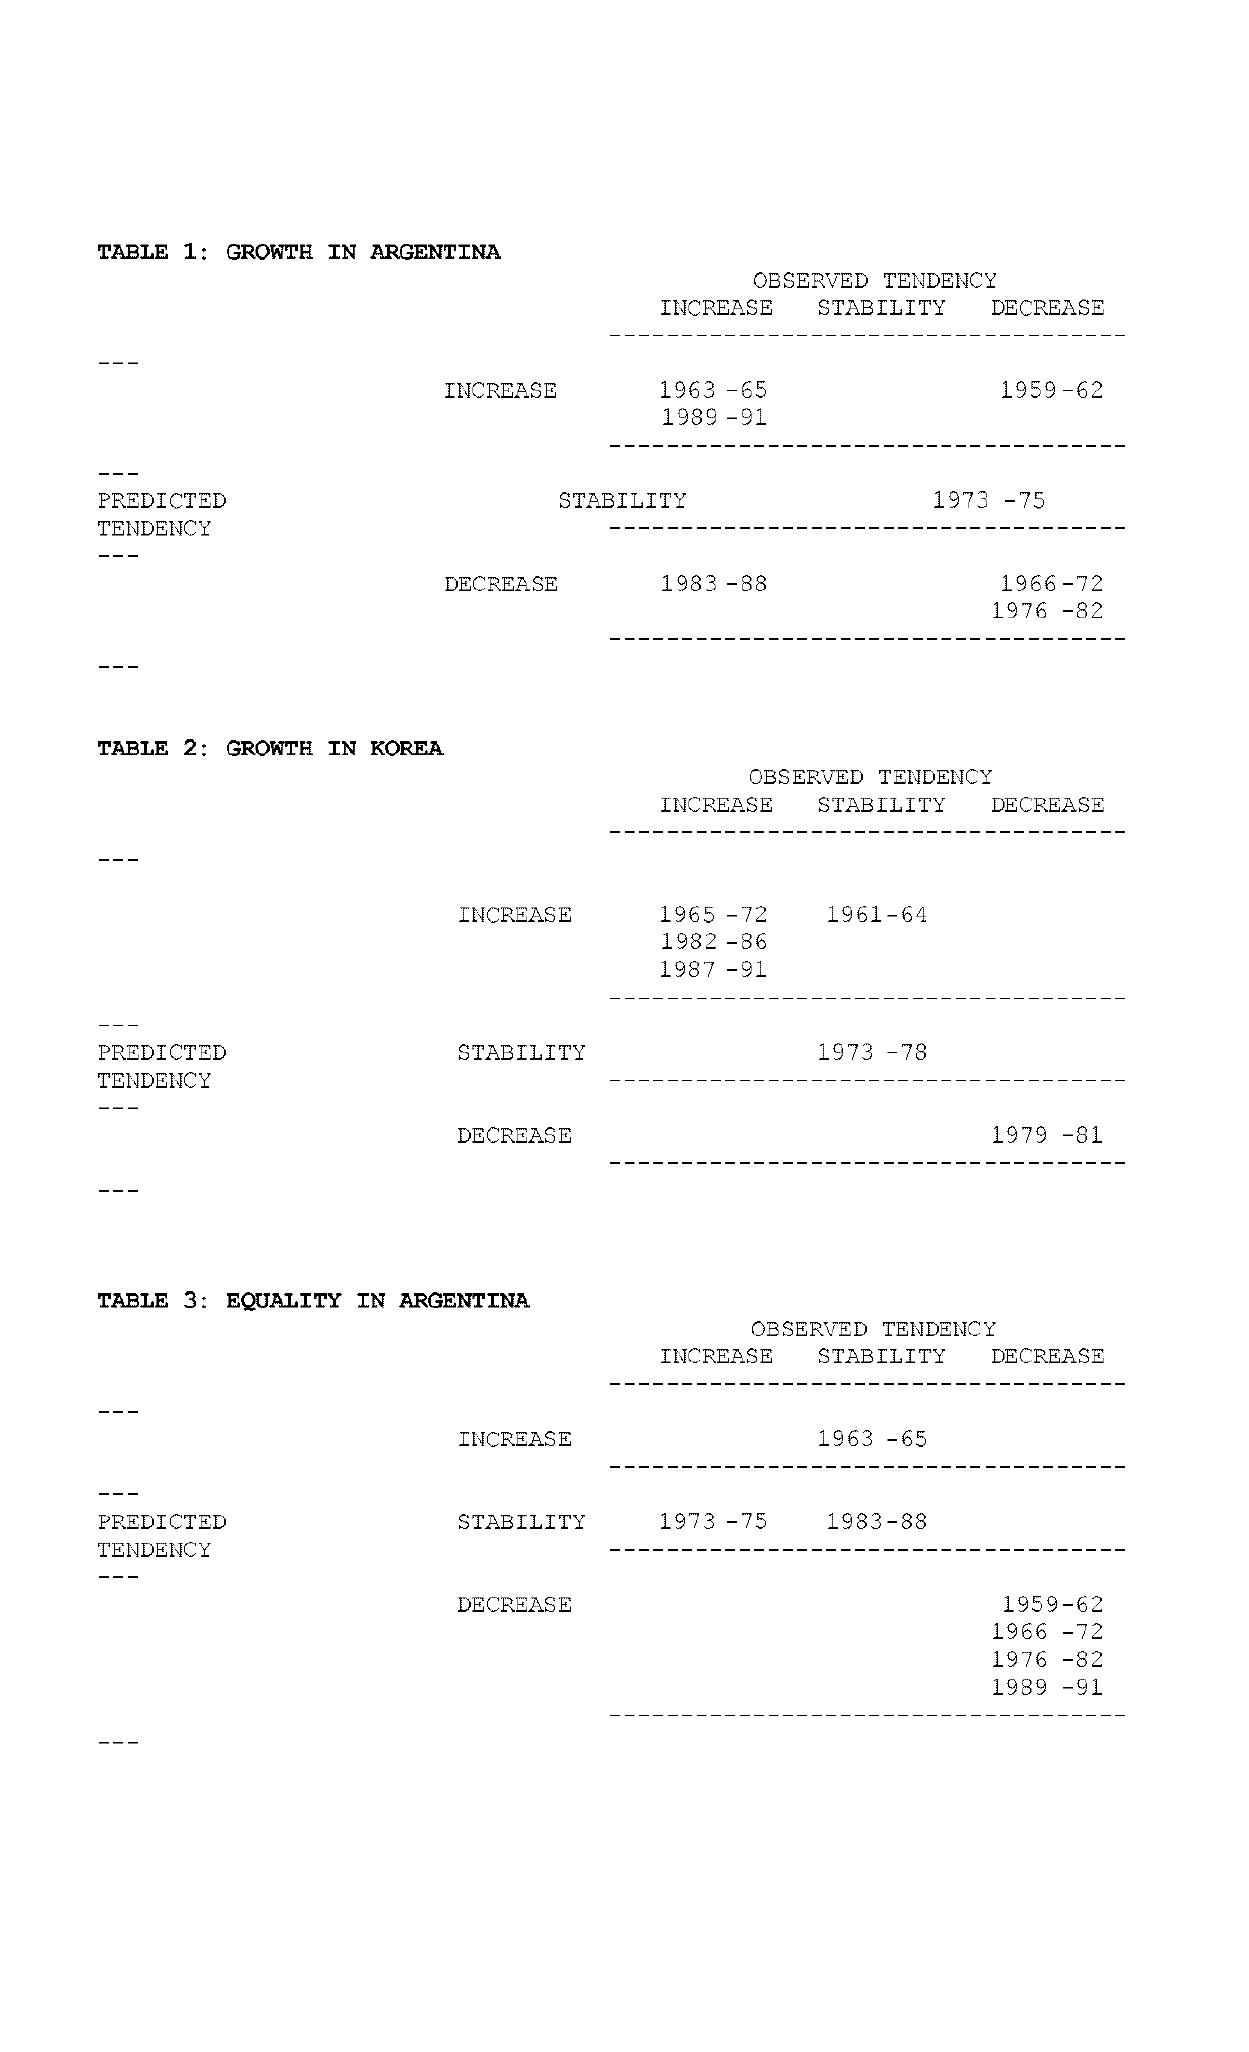
TABLE 1: GROWTH IN ARGENTINA